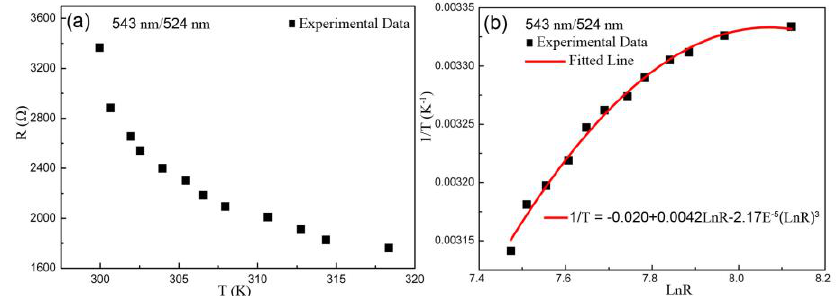
Figure 3. Plots of the ratio of 543 nm / 524 nm including ( a ) the resistance–temperature experimental values, and ( b ) the fitted curve of resistance dependent temperature based on Steinhart – Hart formula.